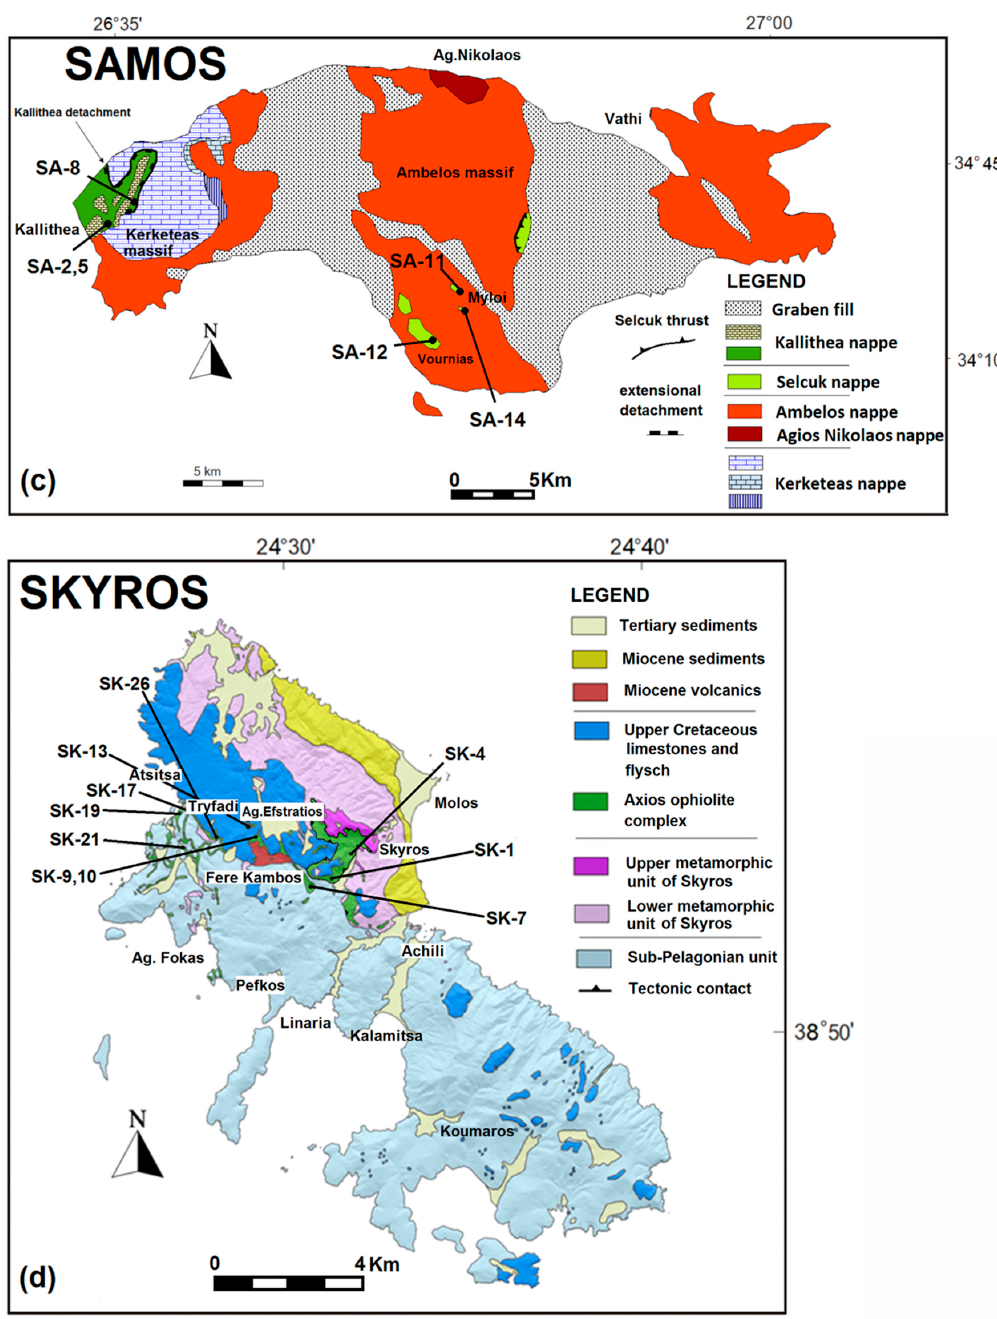
Figure 2. Detailed geological maps of the ( a ) Paros (after [14]); ( b ) Naxos by [8,25]; detailed geological maps of the ( c ) Samos (modified after [26,40]); ( d ) Skyros by [27]). Numbers indicate sample locations. On Samos island six subunits have been distinguished by previous authors (Figures 1c and 2c).